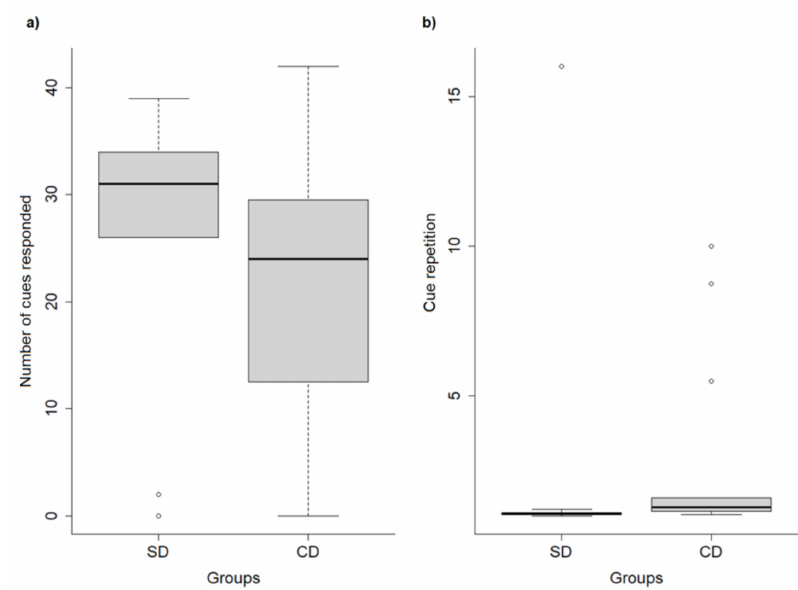
Figure 1. Number of cues responded to ( a ), and cue repetition (“sit” and “paw”) ( b ) in the last training sessions of shelter dogs (SDs) and companion dogs (CDs). Bold horizontal lines represent medians; gray boxes represent quartiles; and thin horizontal lines depict minimum and maximum